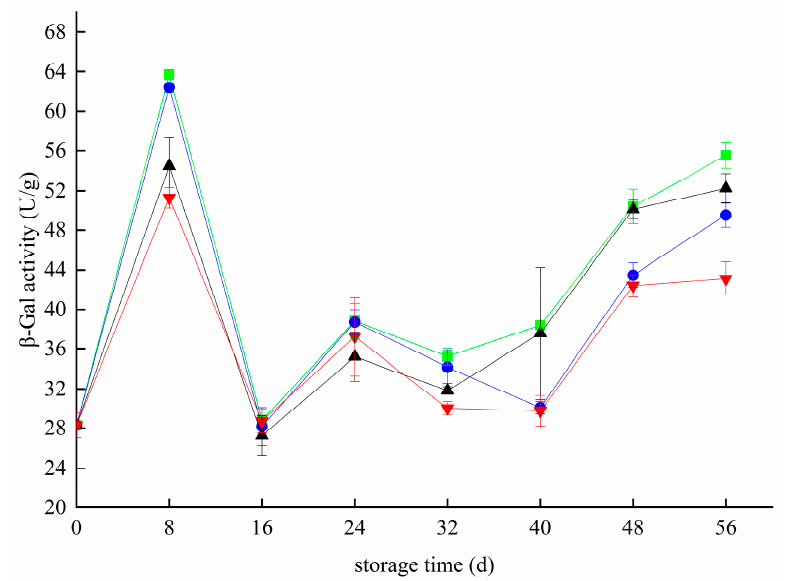
Figure 7. Effect of β -galactosidase activity in blueberry under different treatments. ■ : control; ● : T; ▲ : Z: ▼ : T plus Z.